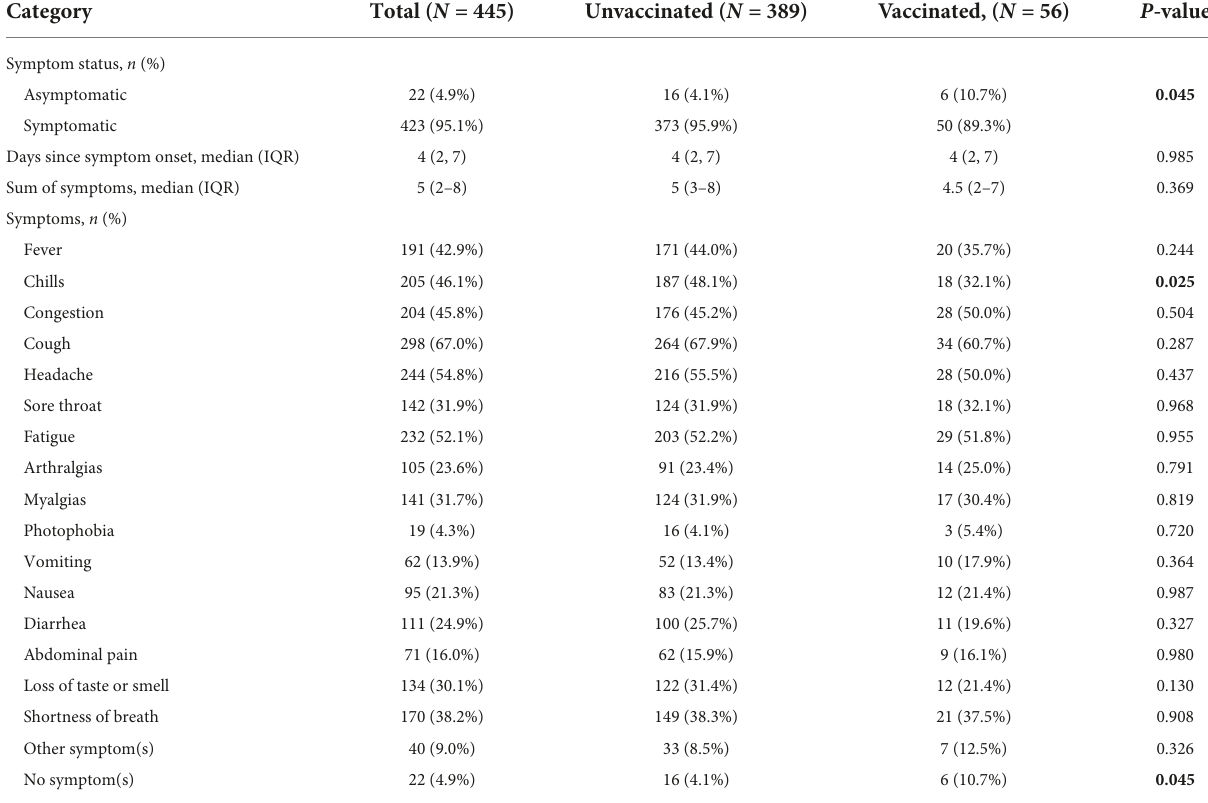
TABLE 3 Clinical presentation of symptoms of SARS CoV-2 (+) unvaccinated and vaccinated [partially ( n = 36) and fully ( n = 20)] groups. Category Total ( N =